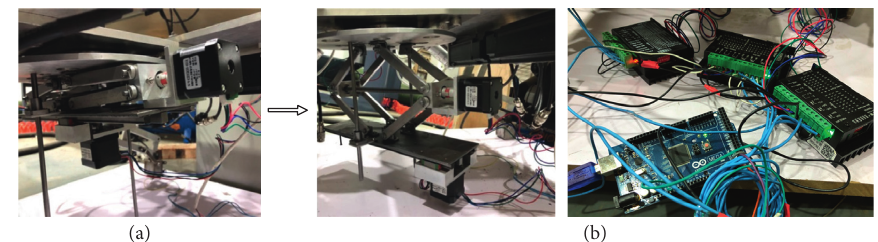
Figure 14: (a) State of BAM before and after adjustment. (b) Control hardware Figure 16. Slope conditions of 0, 5, 10, 15, and 20 degrees are